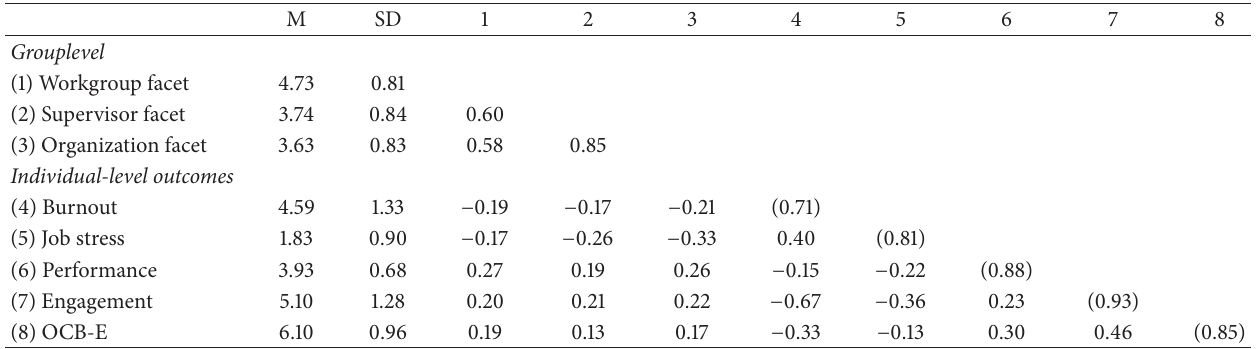
Table 2: Sample 2 correlation